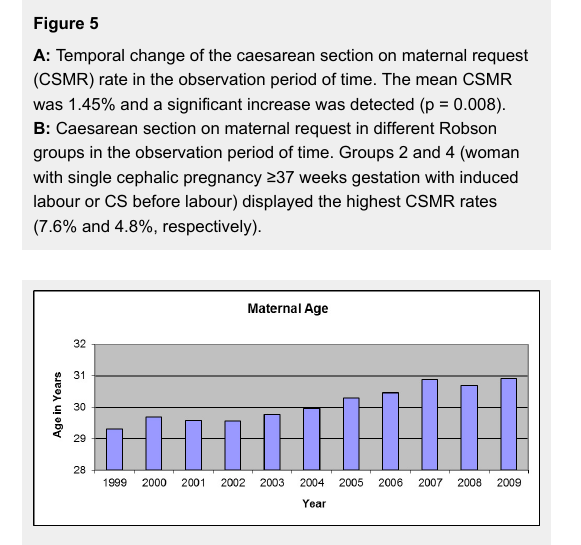
The maternal age increased significantly from 29.3 to 30.9 years in 2009 (p <0.0001).